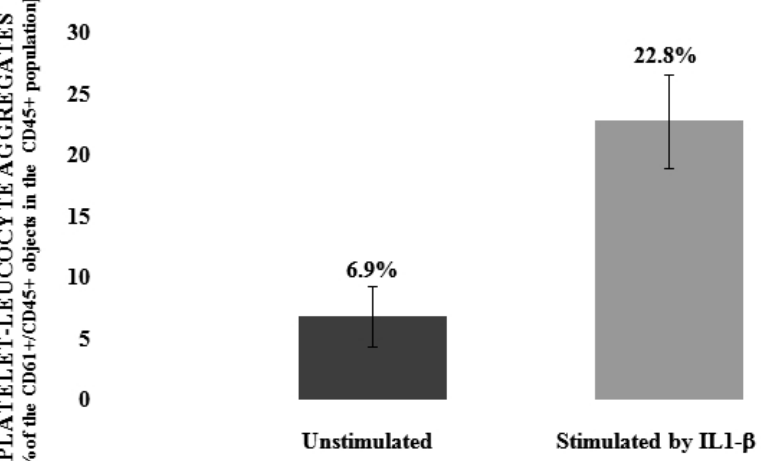
Figure 1. The effect of IL-1 β (10 ng/mL) on the formation of blood platelet-leukocyte aggregates. Results of double-label flow cytometry measurements are expressed as the amount of CD61+/CD45+ objects in the whole CD45+ population (presented as %), n = 12, p < 0.001.